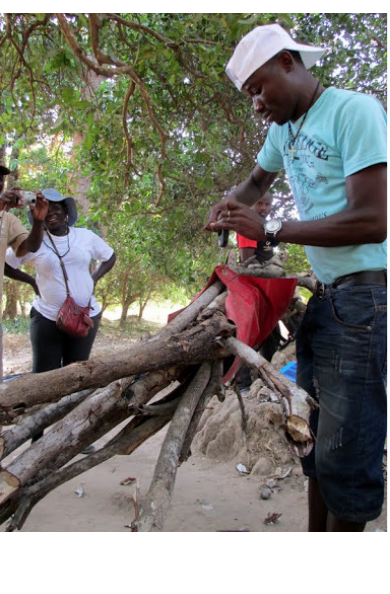
Figure 2. ( a ) and ( b ) weighting the wood collected for one